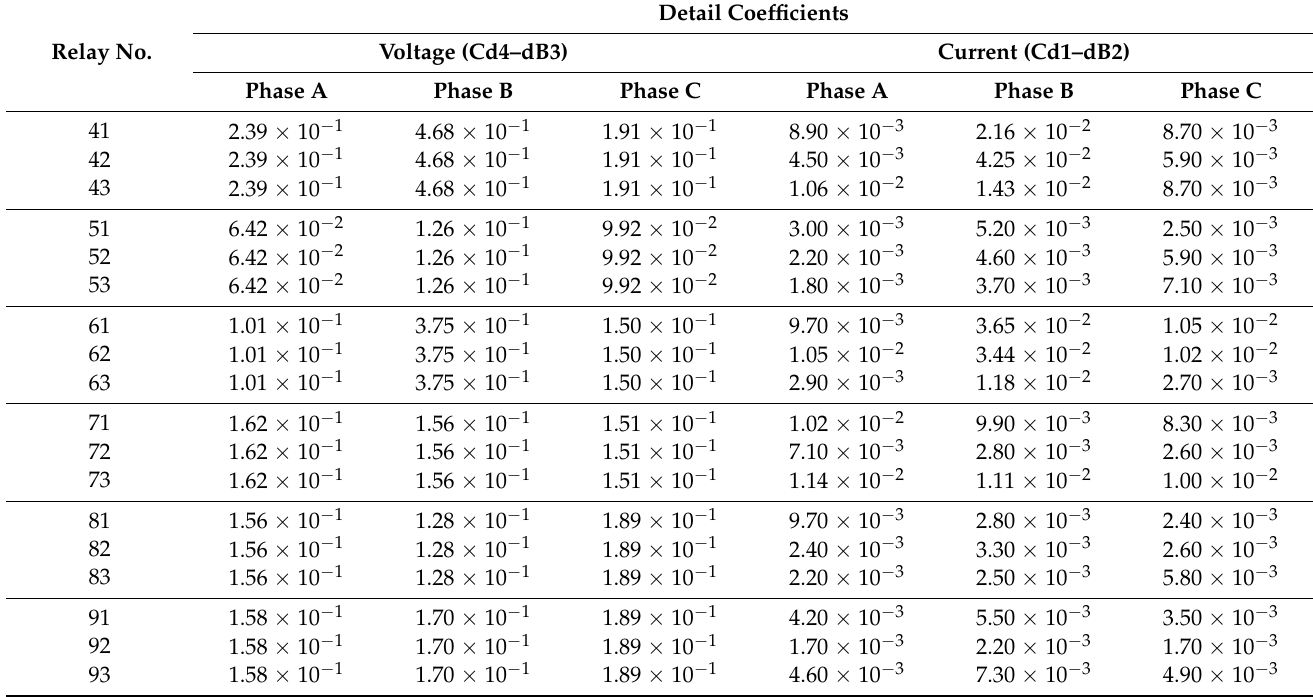
Table 3. Detail coefficients during phase-to-ground arc fault at transmission line from bus 4 to bus